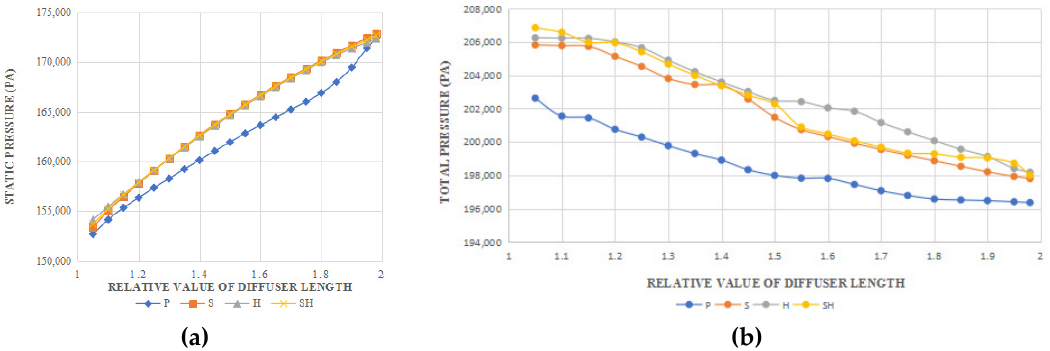
Figure 11. Mean static pressure and total pressure distribution along the diffuser length direction at 1.125 relative mass flow: ( a ) static pressure distribution; ( b ) total pressure distribution.